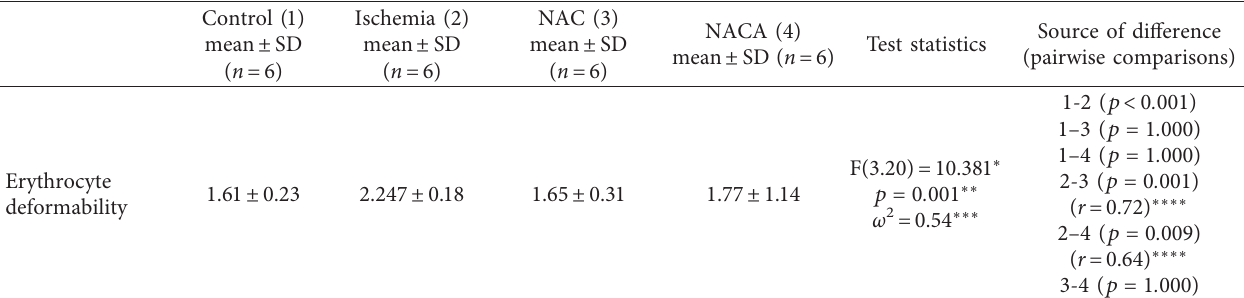
Table 1: Comparison of erythrocyte deformability values between the groups.